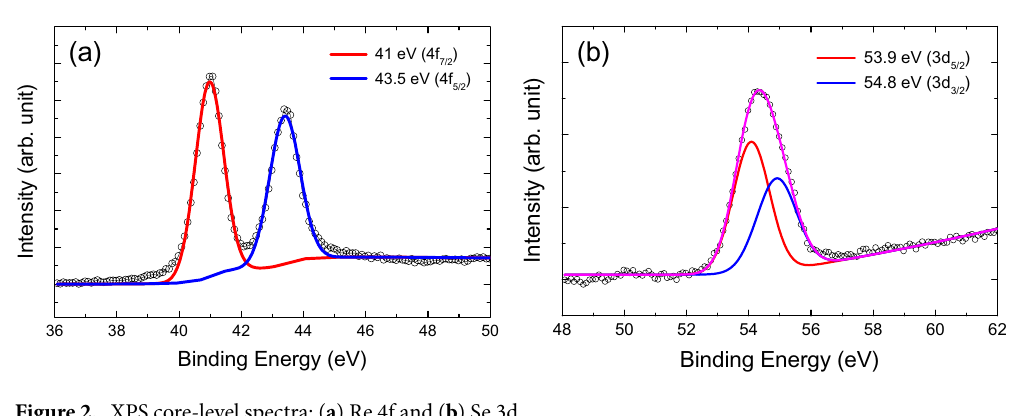
Figure 2. XPS core-level spectra: ( a ) Re 4f and ( b ) Se